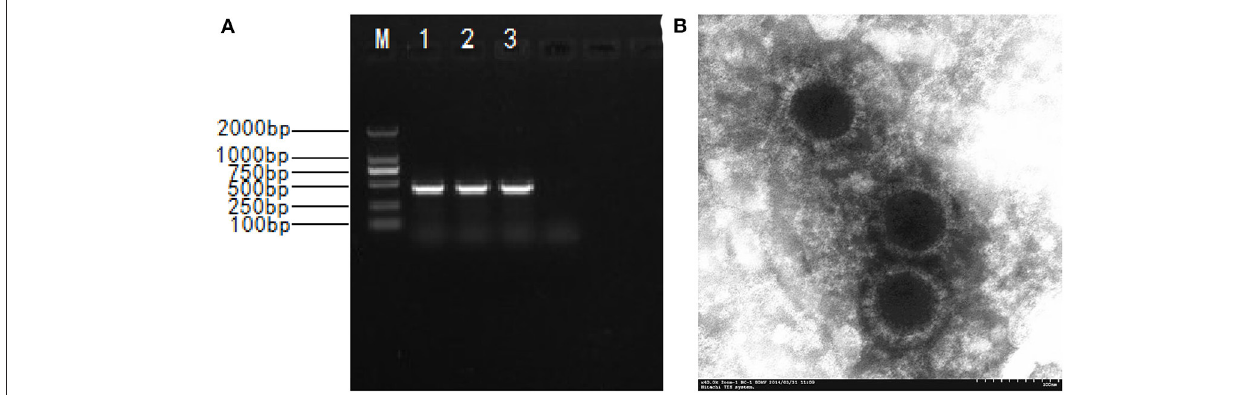
FIGURE 1 | The isolation and identification of the PRV. (A) Amplified PCR product of 429 bp; M. DNA marker DL2000; 1-3. PCR products; 4. Negative control; (B) Electronograph of PRV NY strain.